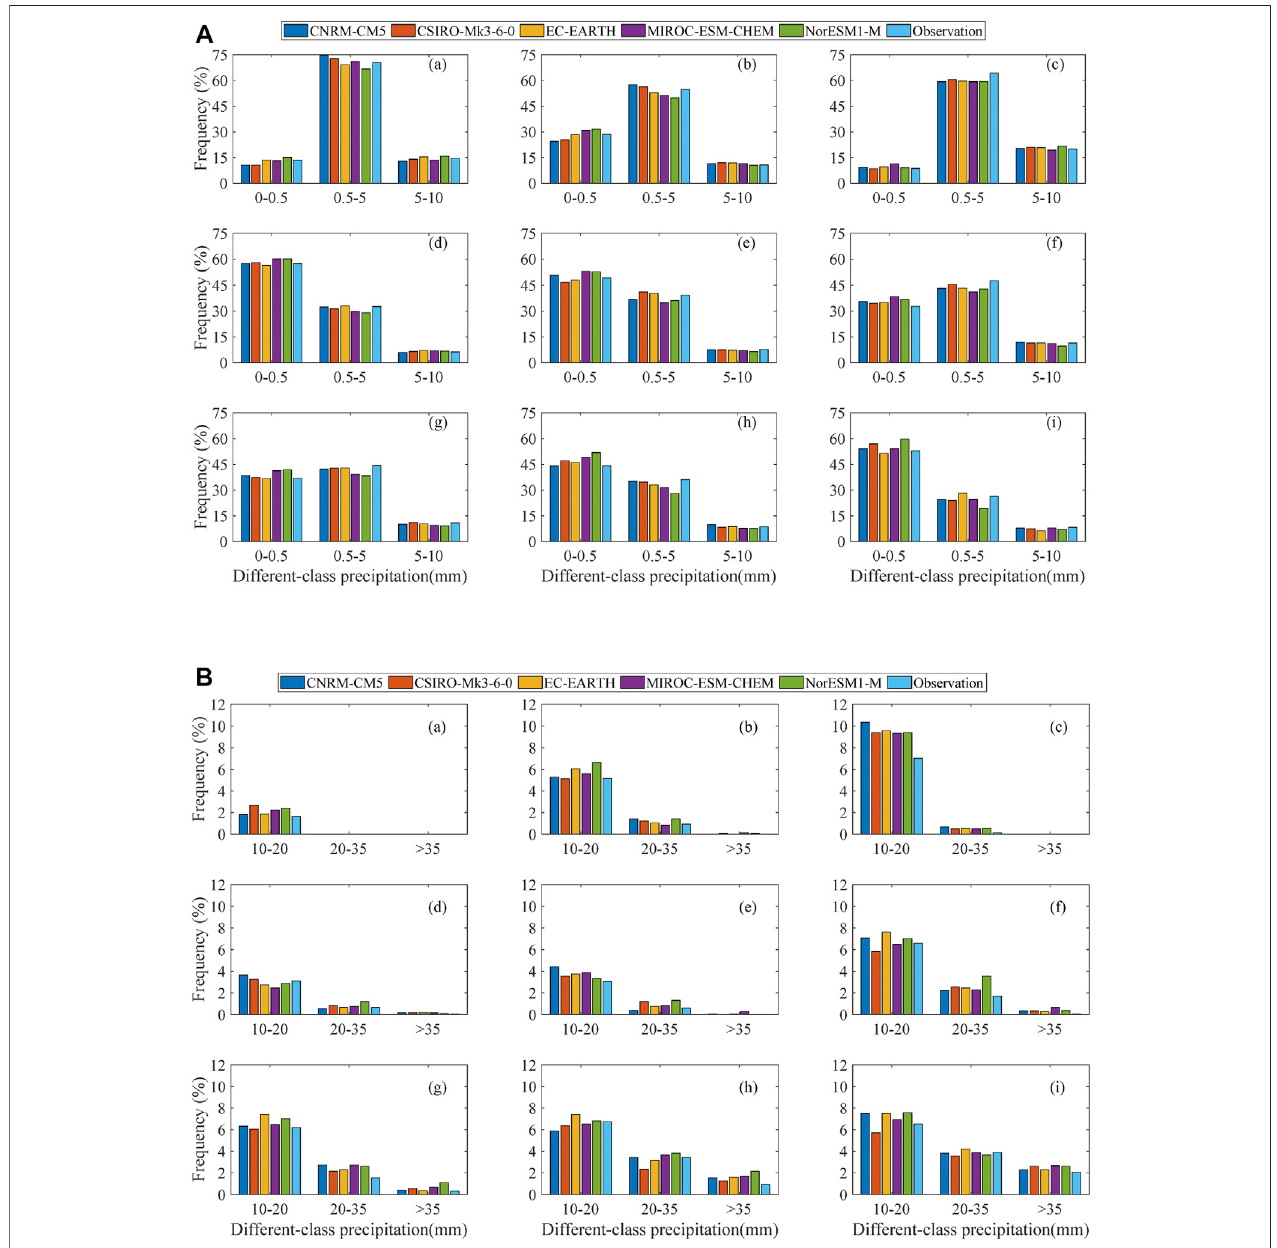
FIGURE 6 | Histogram of the frequency of the simulated different-class precipitation in provinces from the fi ve CMIP5 models [non-rainfall 0 – 0.5 mm day − 1 , very weak 0.5 – 5 mm day − 1 , relatively weak 5 – 10 mm day − 1 , moderate 10 – 20 mm day − 1 , relatively heavy rainfall 20 – 35 mm day − 1 , and very heavy > 35 mm day − 1 : (a – i) represents nine regions of (a) -Qinghai, (b) -Gansu, (c) -Sichuan, (d) -Ningxia, (e) -Inner Mongolia, (f) -Shaanxi, (g) -Shanxi, (h) -Henan, and (i) -Shandong].